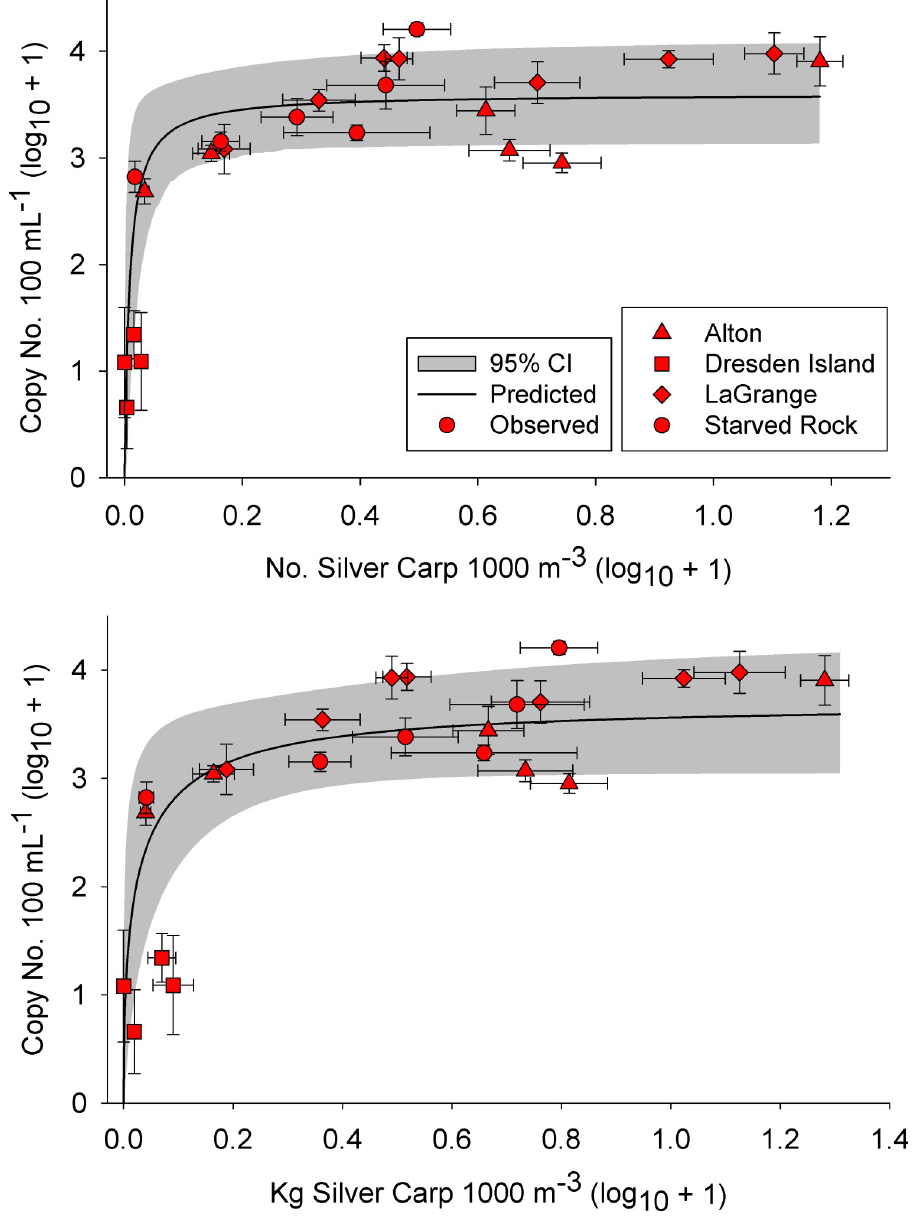
Fig 3. Relationships between site mean (standard error; SE) Silver Carp density and mean (SE) eDNA concentration (SC-TM4 marker) collected from the Illinois River, USA. Symbols represent river reach (see Fig 1) and error bars reflect variability among samples at a